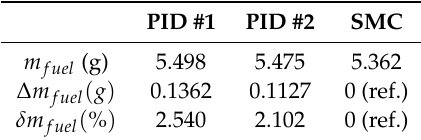
Table 6. Fuel consumption of different control